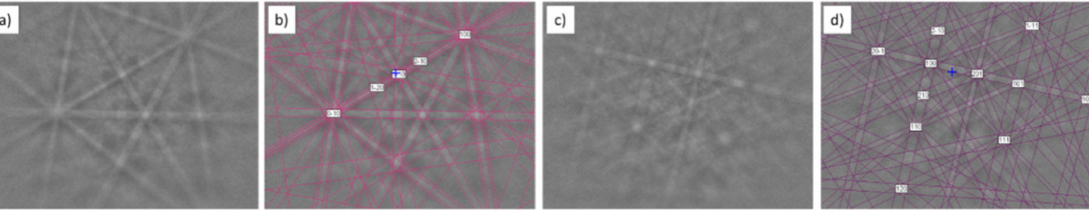
Figure 7. Microstructure and elemental maps of Ti-1%TiC sinter: ( a ) microstructure; ( b ) elemental map of titanium (EDS); ( c ) elemental map of carbon (WDS); ( d ) elemental map of boron (WDS).